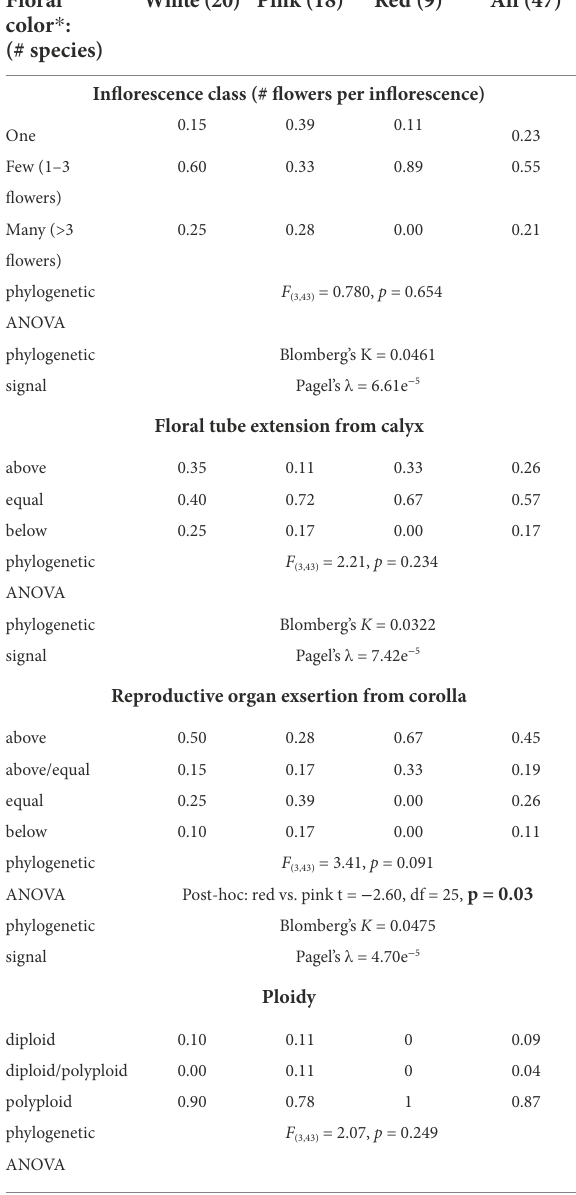
TABLE 2 Summary of proportions per flower color class for each categorical variable inflorescence class (number of flowers per inflorescence), floral tube extension from the calyx, reproductive organ exertion, and